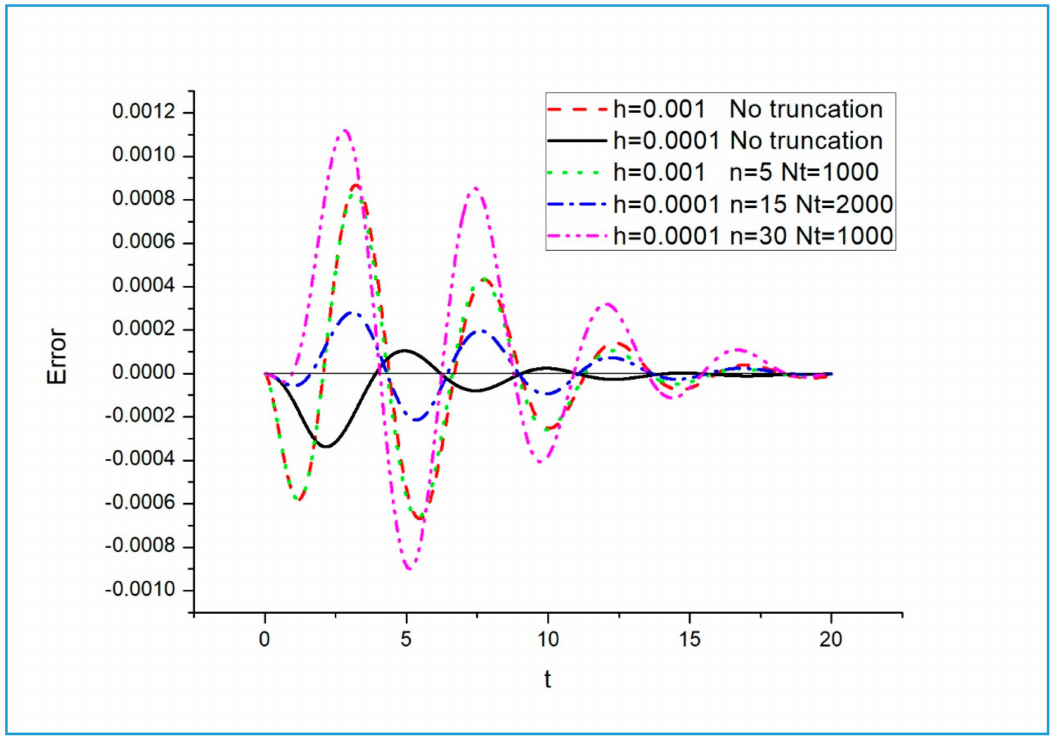
Figure 11. The errors between the two numerical methods (the original defined and the improved SMP) and the Laplace transform